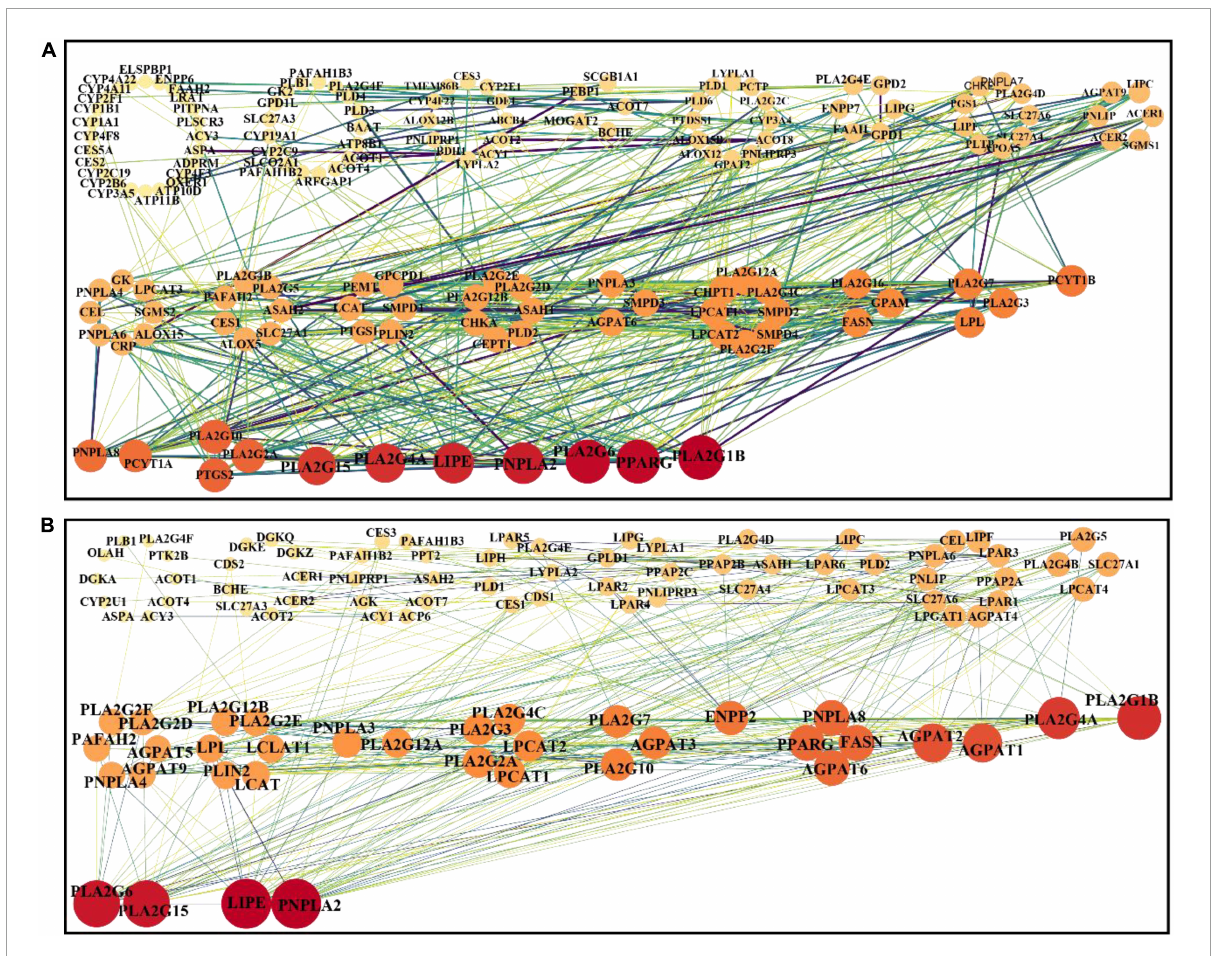
FIGURE6 PPIs network analysis of differential metabolites related proteins. (A) Mod vs. Con, (B) HD vs.